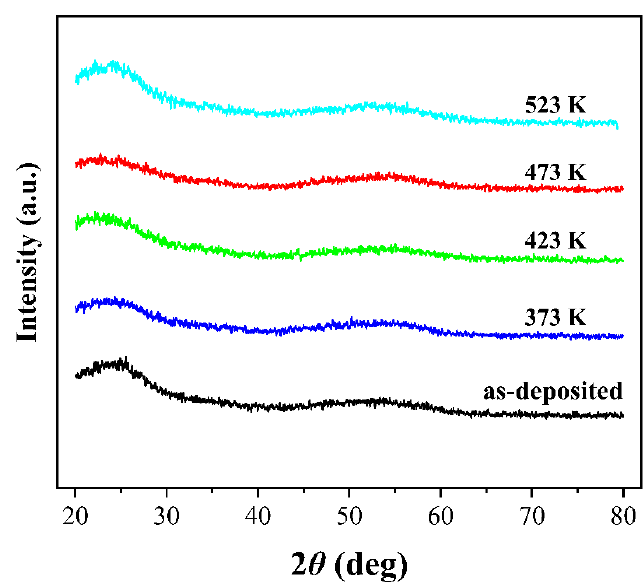
Figure 3. XRD patterns of the films.